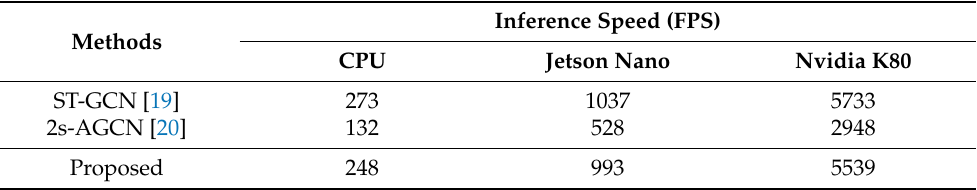
Table 8. Comparisons of STGCN with state-of-the-art GCN-based methods in terms of infer- ence